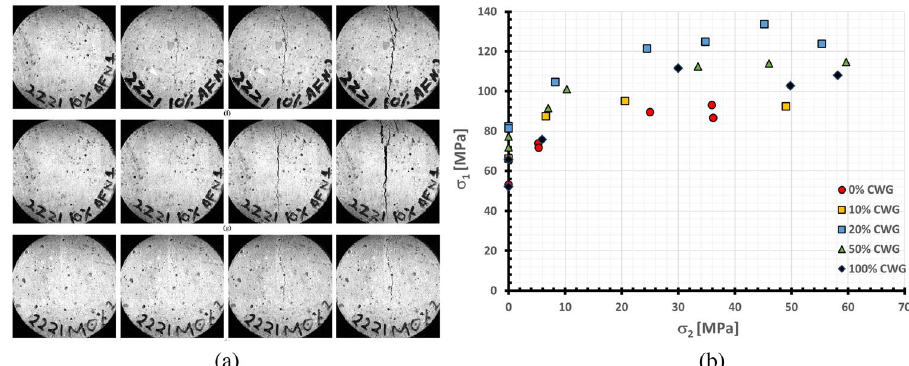
Fig. 6 a High-speed time- lapses of the fracture pattern observed in Brazilian shotcrete samples (captured at 120,000 frames per second) com- pressed between at horizontal platens according to ASTM rec- ommendations, and b Biaxial strength results for different types of shotcrete mixes under biaxial compressions